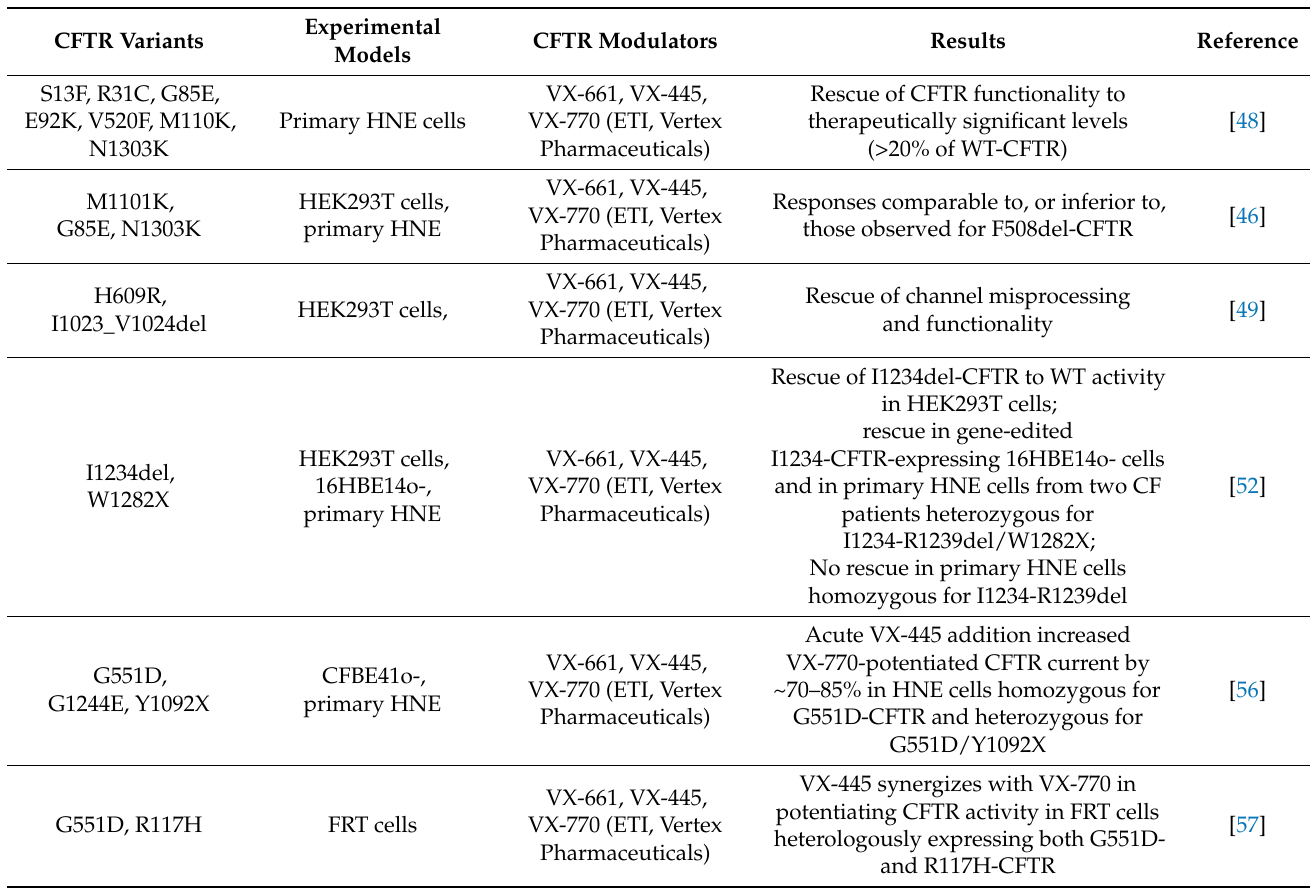
Table 1. Rare CFTR variants rescued by approved CFTR modulators in preclinical